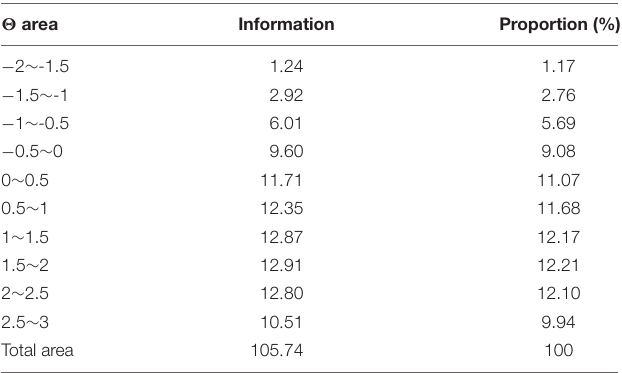
TABLE 6 | Information Value for Each